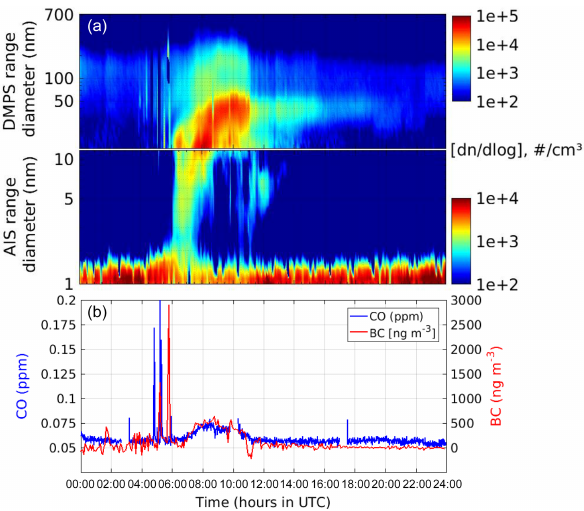
Figure 3. The 6 July 2015 diurnal variation in (a) negative ions (1–10nm) and (10–700nm) aerosol particle size distribution (note the different concentration scales for ion number and particle con- centrations) and (b) both BC and CO concentration variations in ngm − 3 andppm